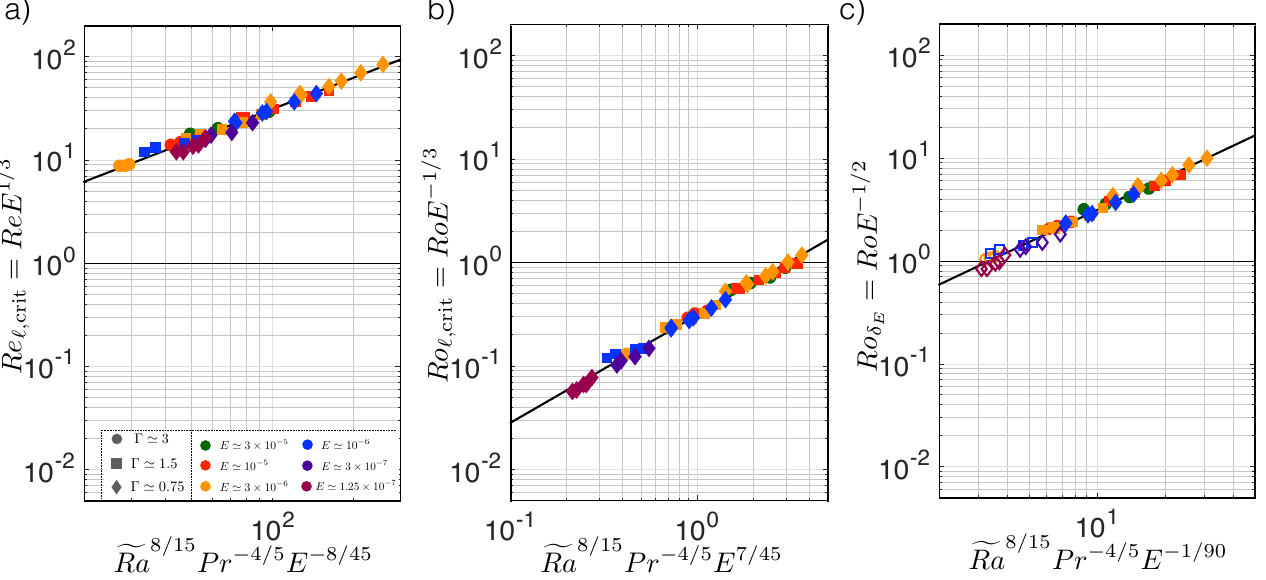
Figure 11. ( a ) Local Reynolds number, Re (cid:96) ,crit , versus its scaling prediction given by (41a), 8/15 Ra Pr − 4/5 E − 8/45 . ( b ) Local Rossby number, Ro (cid:96) ,crit , versus Equation (41b), ( c ) Local boundary layer Rossby number, Ro δ (cid:102) colors and symbol shapes are consistent with those in Figure 10. All best fit black lines yield a fit of y 0.3 x 1.0 , indicating that the predicted x-parameter in each panel does indeed collapse the local (cid:39) estimate plotted on the